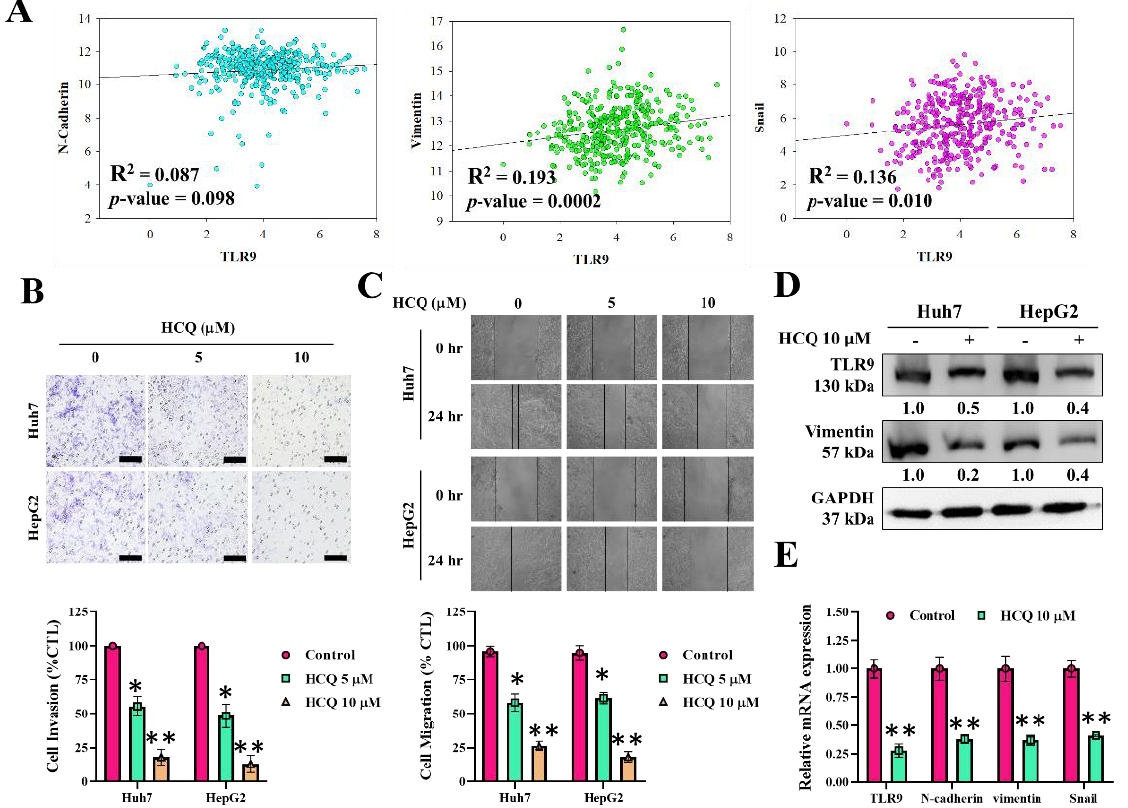
Figure 4. HCQ inhibited HCC cancer cells’ oncogenic and invasive properties. ( A ) Correlation analysis of TLR9 expression with EMT associate marker expression. ( B , C ) HCQ significantly inhibited HCC (Huh7 and HepG2) cell invasive and migratory abilities. The representative bar plot represents the quantification of invasion and migratory abilities after HCQ treatment calculated by ImageJ, provided in ( B ) (below) and ( C ) (below), respectively. ( D ) Western blot analysis of expression of TLR9, and EMT marker (vimentin); GAPDH was used as an internal control. Representative protein bands are shown a reduction in expression of TLR9 and vimentin observed after the HCQ treatment (10 µ M). ( E ) The mRNA expression level of TLR9 and EMT markers (N-cadherin, vimentin, and Snail2) were determined using real-time qRT-PCR; GAPDH was used to normalize the expression levels. Data are the mean ± SEM of three independent experiments. * p < 0.05, ** p <